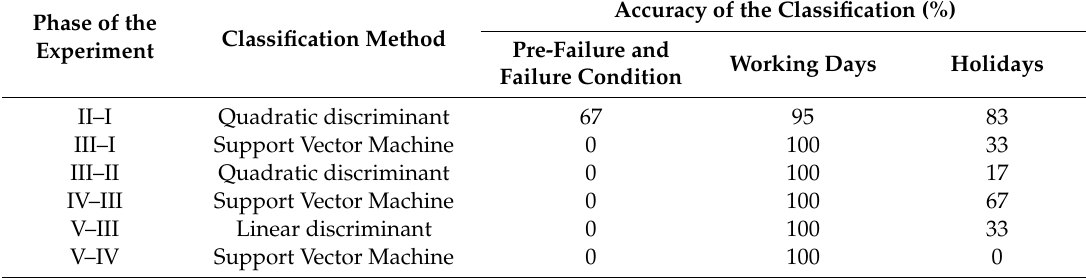
Table 4. Values of true positive rates (TPR) for individual system operating states for individual phases of the